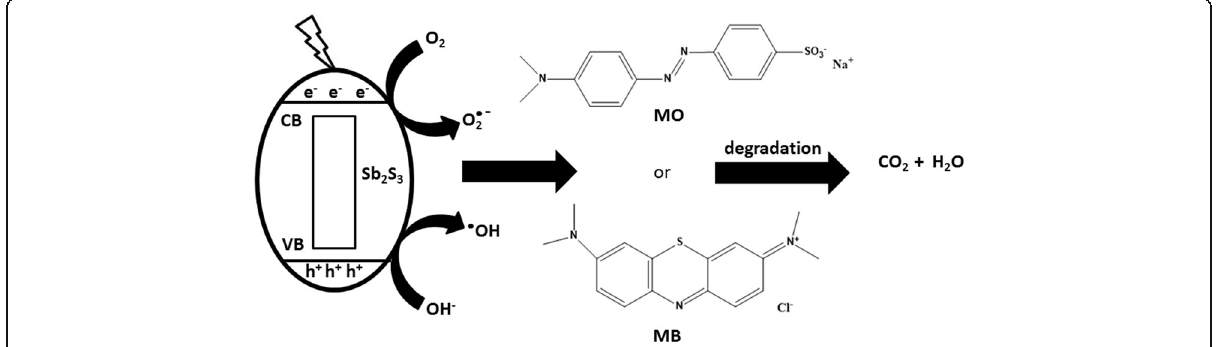
Fig. 12 Schematic diagram of a possible process of visible-light-driven photodegradation of MO and MB by Sb 2 S